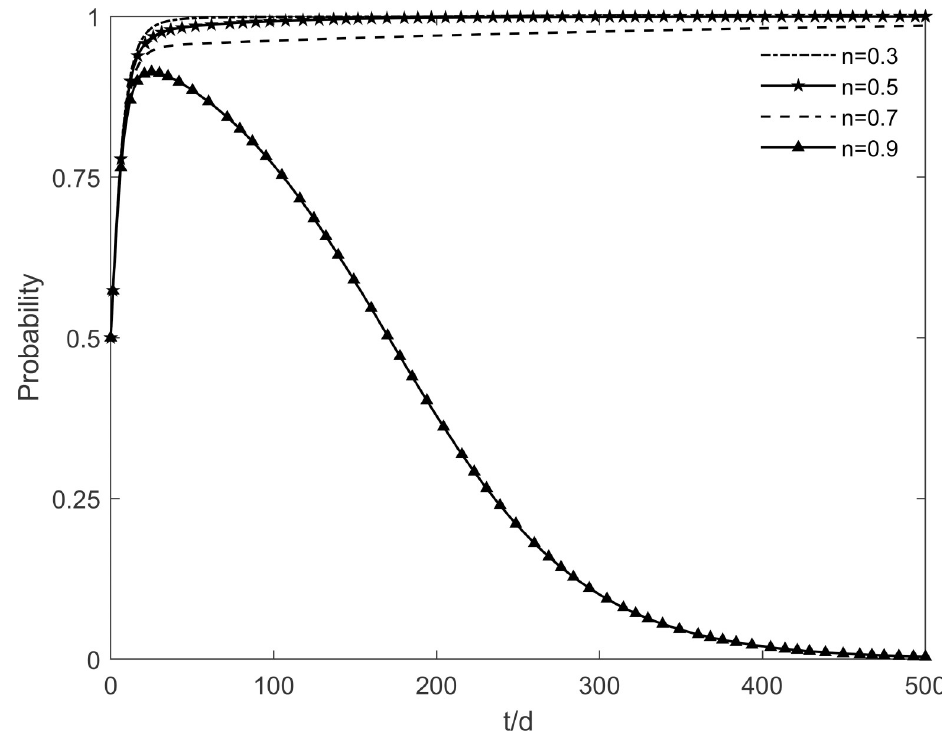
Fig 12. The impact of n on the government’s strategic